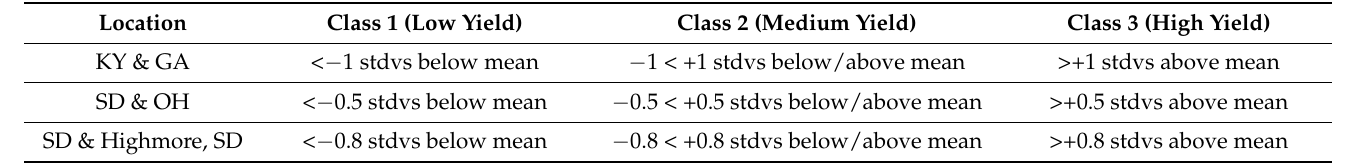
Table 3. We calculated the standard deviations (stdvs) of the yields to assign class labels for yields in each location; we used three different thresholds (1, 0.8, 0.5) to avoid high class